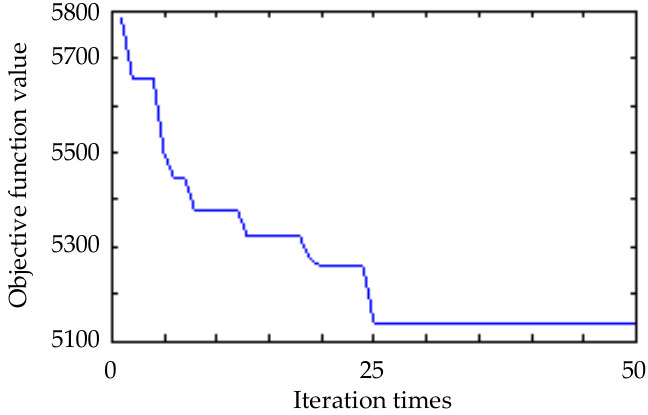
Figure 7. The objective function value vs. iteration times.